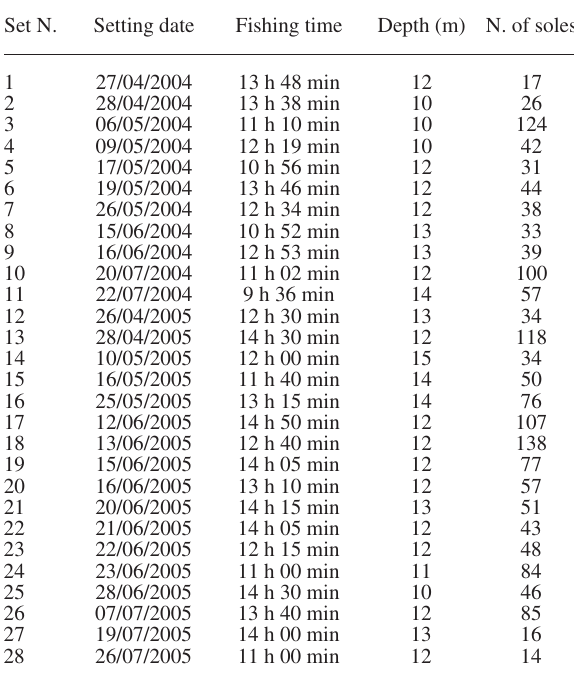
Table 2. – Fishing trials carried out with the experimental gill nets. The gill net used in each set had a length of 2112 m. Set